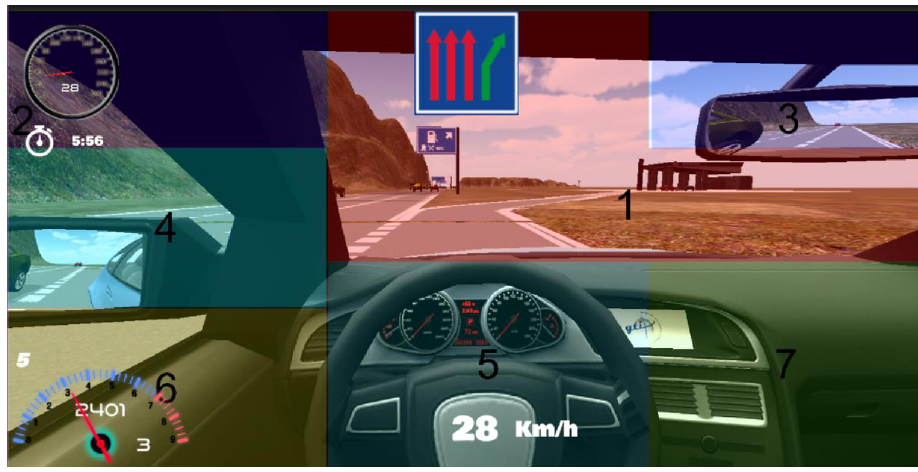
Sensors 2021 , 21 , x FOR PEER REVIEW Figure 2. Simulator scene with the seven regions considered for the gaze estimation analysis.